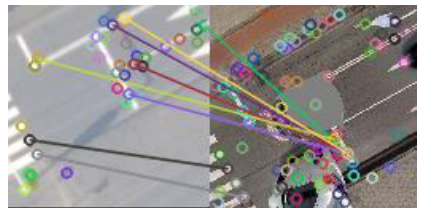
Figure 11 Matched SIFT keypoints in the second scene and first